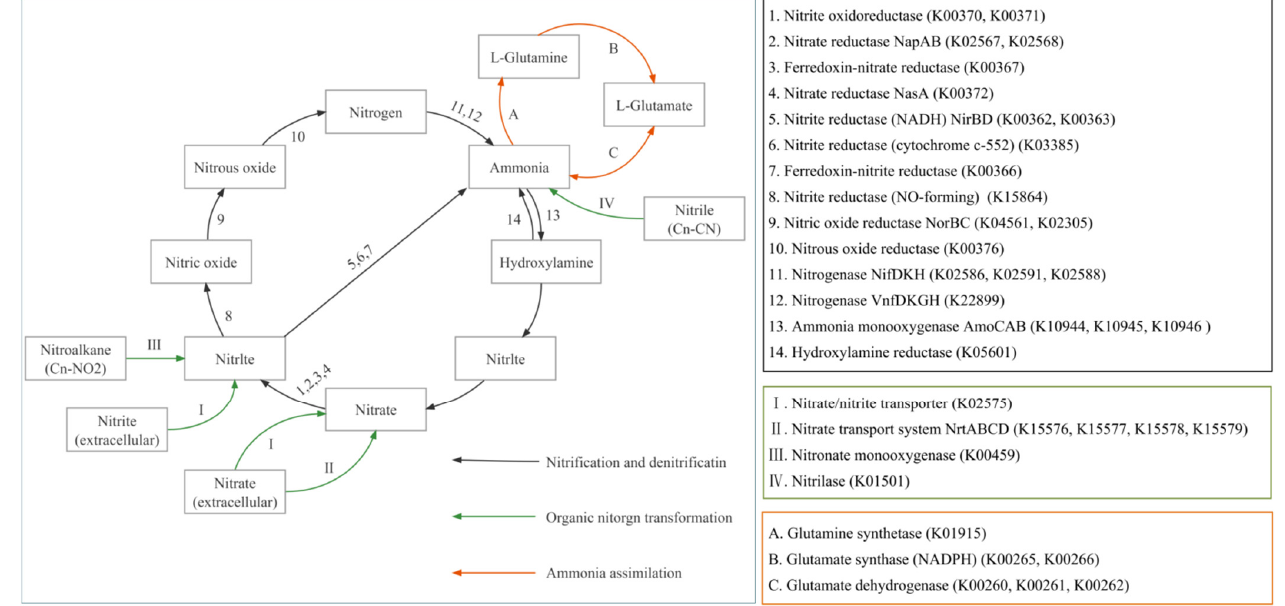
Figure 4. Map of the nitrogen cycling pathways and processes annotated in the pond sediments.